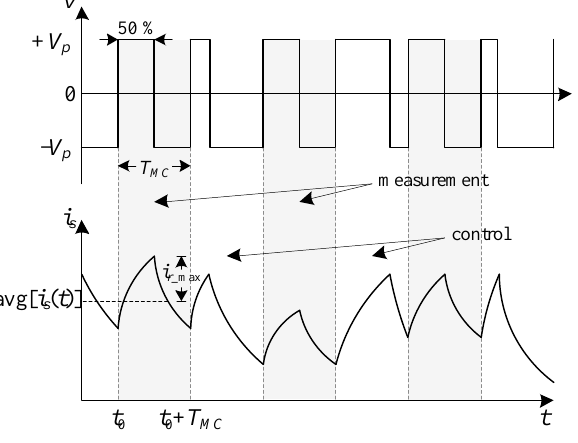
Figure 4. Raw coil voltage and current showing measurement and control